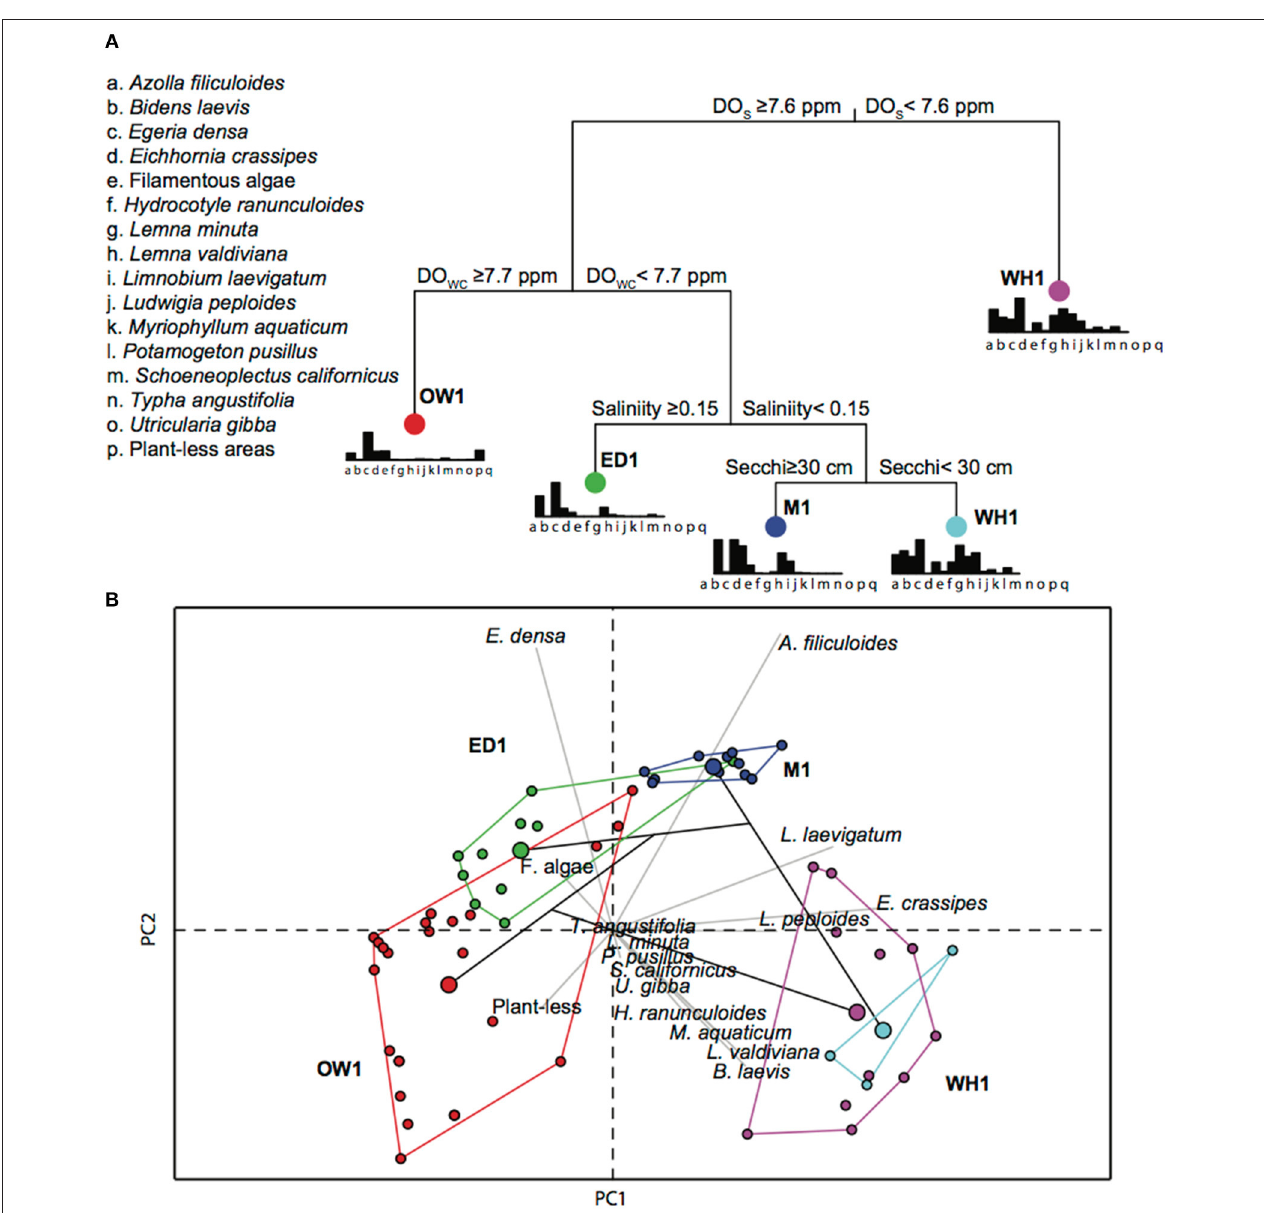
FIGURE 2 | (A) Example of one of the fifteen multivariate regression tree (MRT) analyses on current macrophyte species frequency of occurrences and selected limnological variables at four distinct transects with characteristic vegetation: WH1 (purple dot), Eichhornia crassipes; ED1 (green dot), Egeria densa; M1 (blue dot), mixed assemblage of macrophyte species; and OW1 (red dot), open waters. DOS, dissolved oxygen at the surface; DOwc, dissolved oxygen at 50 cm water depth; (B) Principal component analysis (PCA) showing macrophyte associations according to the four selected groups (colored lines) revealed by the MRT. Colored dots within each group represents the macrophyte sampling points (beginning, middle and end) across each transect over five fieldwork campaigns. The larger colored dot within each group represents the group centroid